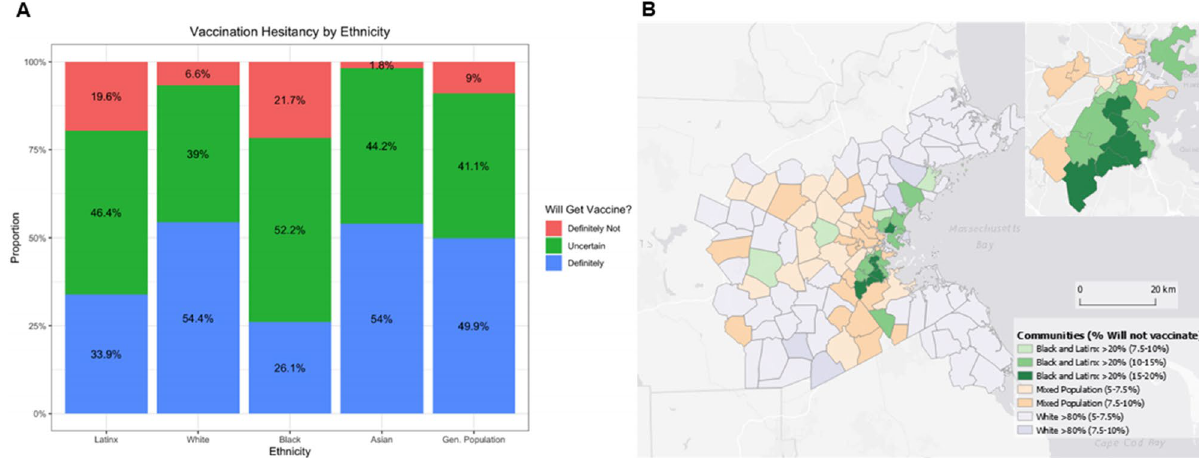
Figure 1. Representation of variations in vaccine intentions. ( A ) Individuals vary in their intentions to receive the vaccine by ethnicity. When combined with ( B ) the categorization of communities by predominantly White (> 80%), high Black–Latinx (> 20%), or other, these disparities translate into geographic differences in the proportion who definitely will not vaccinate. (Made in R Studio V.1.4. http:// www. rstud io.